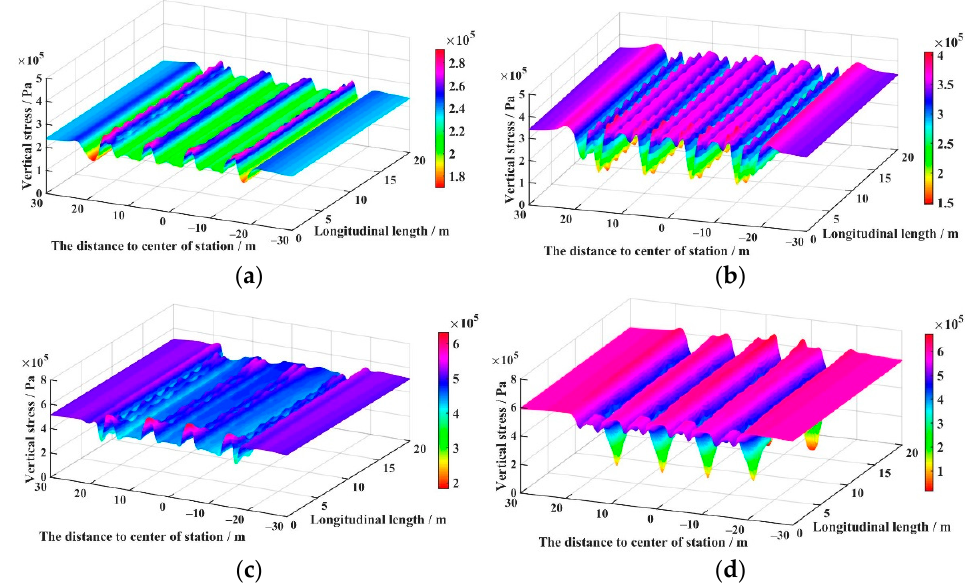
Figure 6. Stress fields of scheme 2 (S-1-4-2-3-5-8-6-7): ( a ) P1 (z = 4.5 m), ( b ) P2 (z = 0 m), ( c ) P3 (z = − 8.3 m), and ( d ) P4 (z = − 12.8 m).